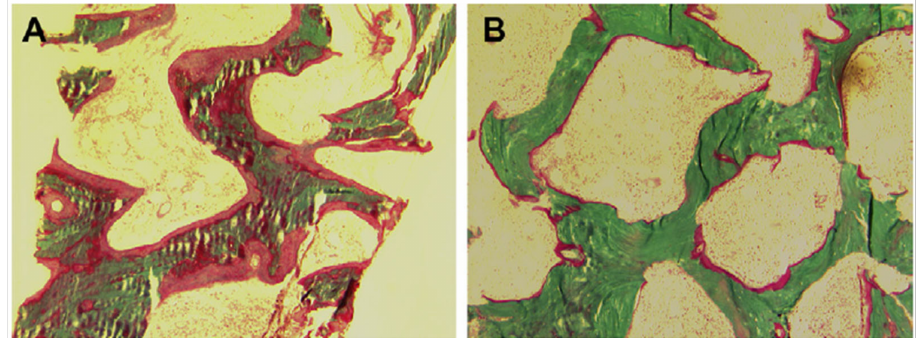
Figure 2. Reversibility of osteomalacic histopathological features after proper correction of vitamin D deficiency: the increased amount of osteoid (in red) deposited over poorly mineralized trabecular bone (green) (panel ( A )) is decreased in surface and thickness (panel ( B )) (reproduced with permission from ref.